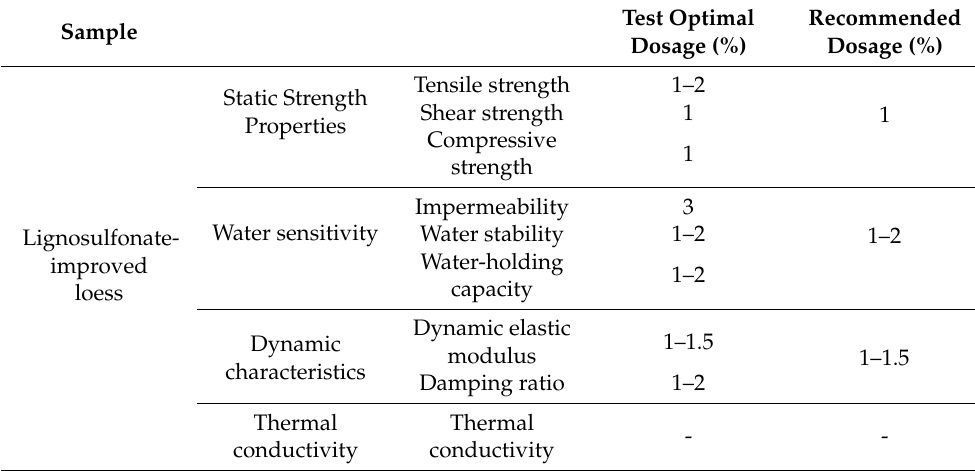
Table 2. Recommended optimal dosage of lignosulfonate-improved